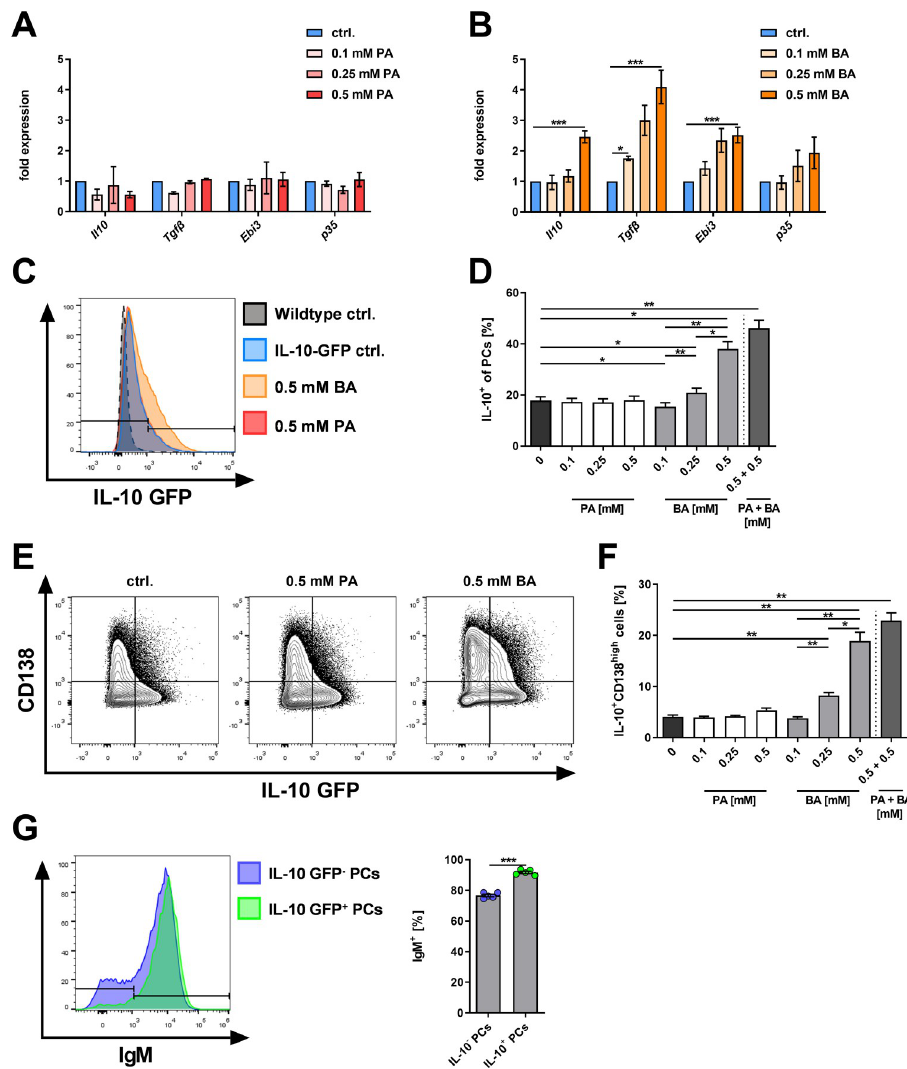
Fig 2. Butyrate promotes the expression of IL-10 in isolated murine B cells. (A, B) Gene expression of anti- inflammatory cytokines after 4 days of B cell culture with increasing concentrations of (A) PA (n = 2–5) or (B) BA (n = 3–14). (C, D) Representative histogram plot and frequencies of IL-10 GFP protein expressing cells among all induced CD138 high PCs after 4 days of B cell culture with increasing concentrations of PA and/ or BA (n = 5). (E, F) Representative contour plots and frequencies of IL-10 + CD138 high PCs among all murine B cells after 4 days of B cell culture with increasing concentrations of PA and/or BA (n = 5). (G) Representative histogram plot and frequencies of IgM + cells among IL-10 + and IL-10 - CD138 high PCs. � p < 0.050, �� p < 0.010, ��� p <